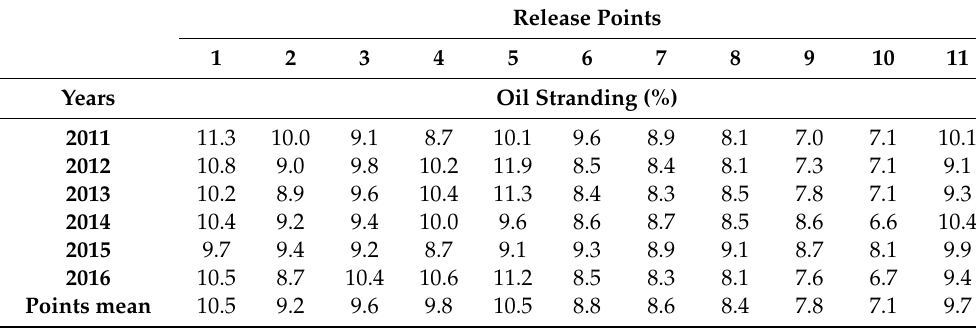
Table 1. Annual percentages (%) of stranded oil elements for the entire coastline, released from the 11 study points (Figure 1).